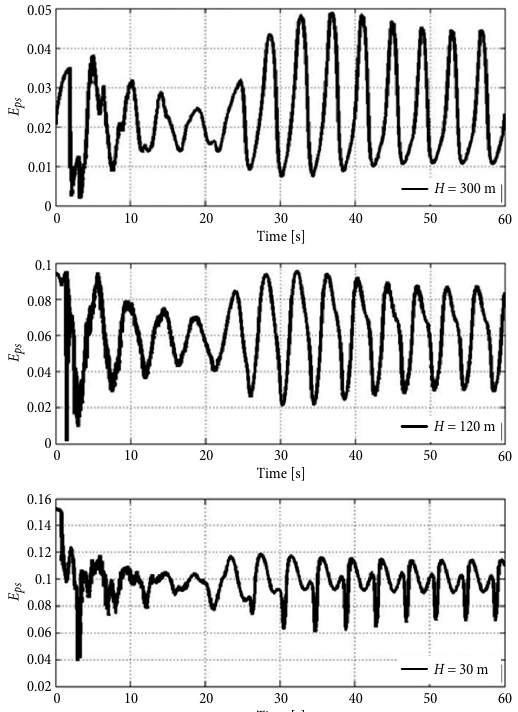
Fig. 11. Spectrum of the amplitude of flow in the 1st, 10th, and 16th stages of the centrifugal pump, when =